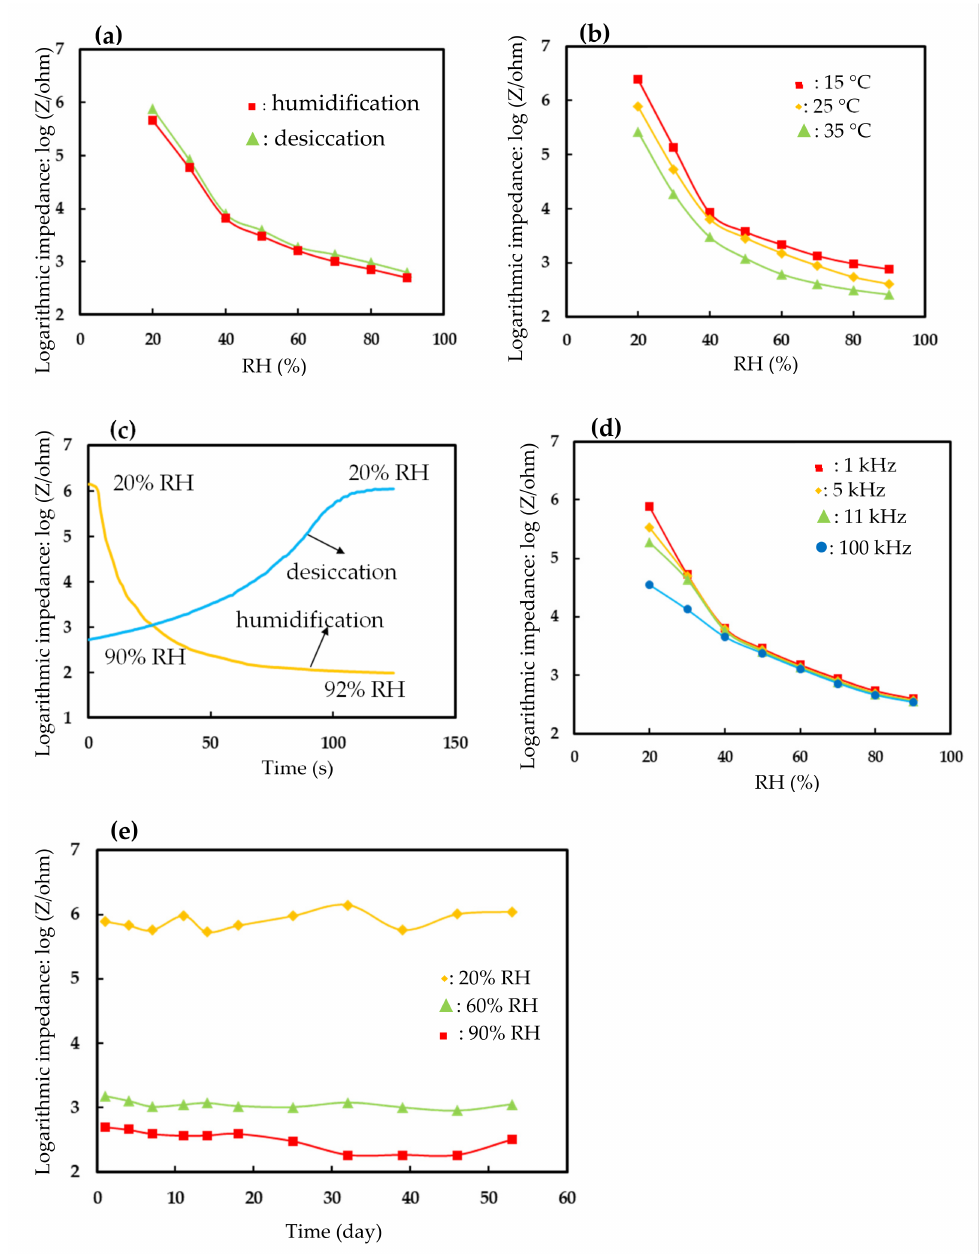
Figure 5. Humidity-sensing properties of the humidity sensor based on 7 wt% EuCl 2 /Eu 2 O 3 blend film. ( a ) Hysteresis, ( b ) effect of ambient temperature, ( c ) response/recovery times, ( d ) effect of applied frequency, ( e ) long-term